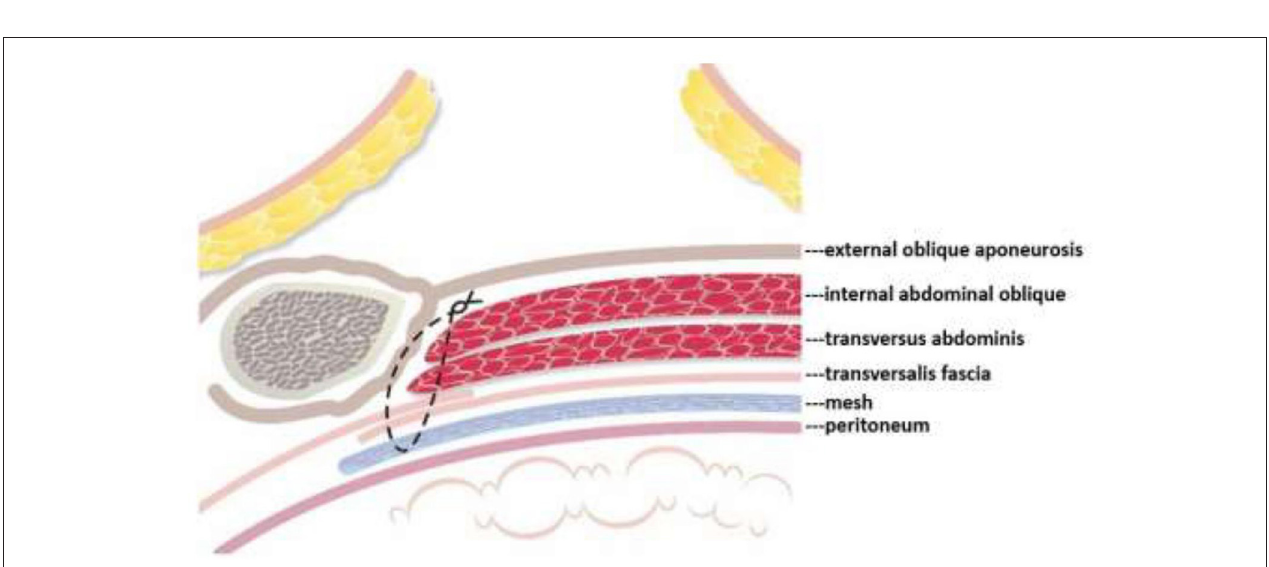
FIGURE 6 | Following mesh repair, the posterior abdominal wall is only protected by a mesh patch and a single layer of autologous tissue—the transversalis fascia.